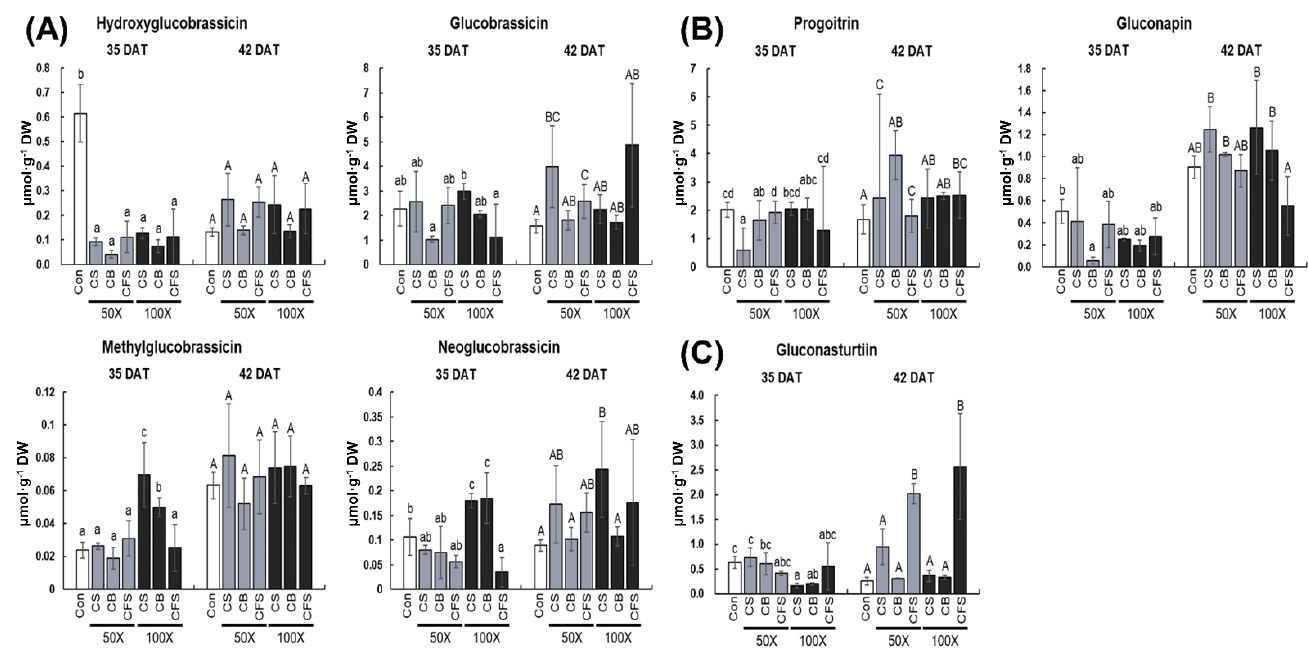
Figure 6. Individual glucosinolate contents ( µ mol · g − 1 DW) in “Red Russian” kale after Chlorella treatments. In total, seven glucosinolates were determined, including ( A ) indole (hydroxyglucobrassicin, glucobrassicin, methylglucobrassicin, and neoglucobrassicin), ( B ) aliphatic (progoitrin and gluconapin), and ( C ) aromatic glucosinolates (gluconasturtiin). Bars represent the mean ± SD of three replicates. Different letters indicate significant differences at p < 0.05 based on Duncan’s multiple range tests. Con, distilled water; CS, Chlorella suspension; CB, Chlorella biomass; CFS, Chlorella − free supernatant; and DW, dry weight.